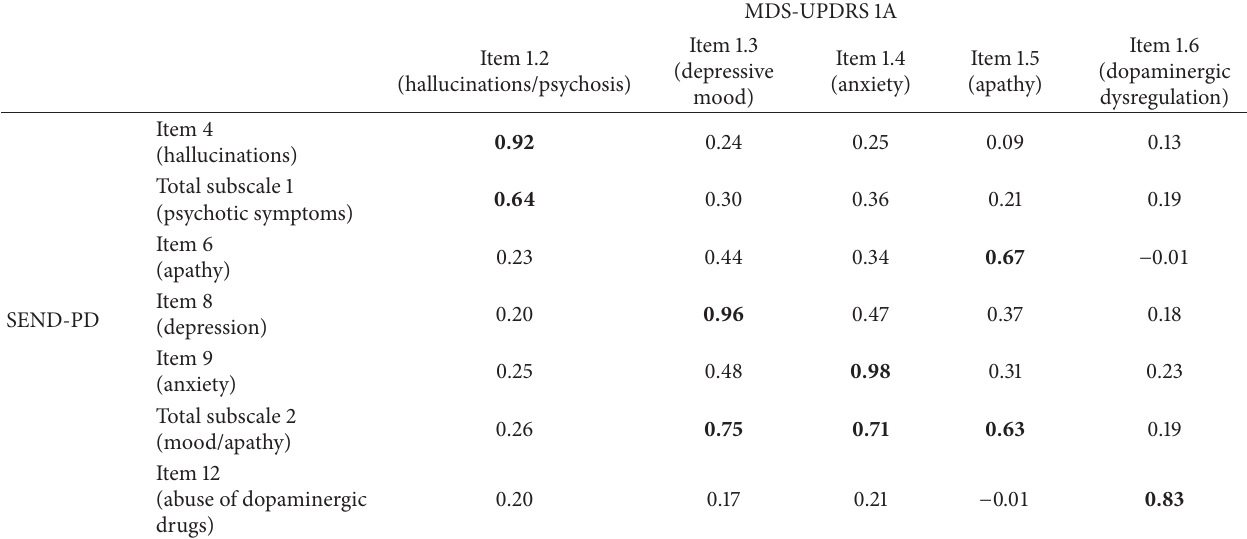
Table 3: Correlation between SEND-PD and MDS-UPDRS part IA related items and